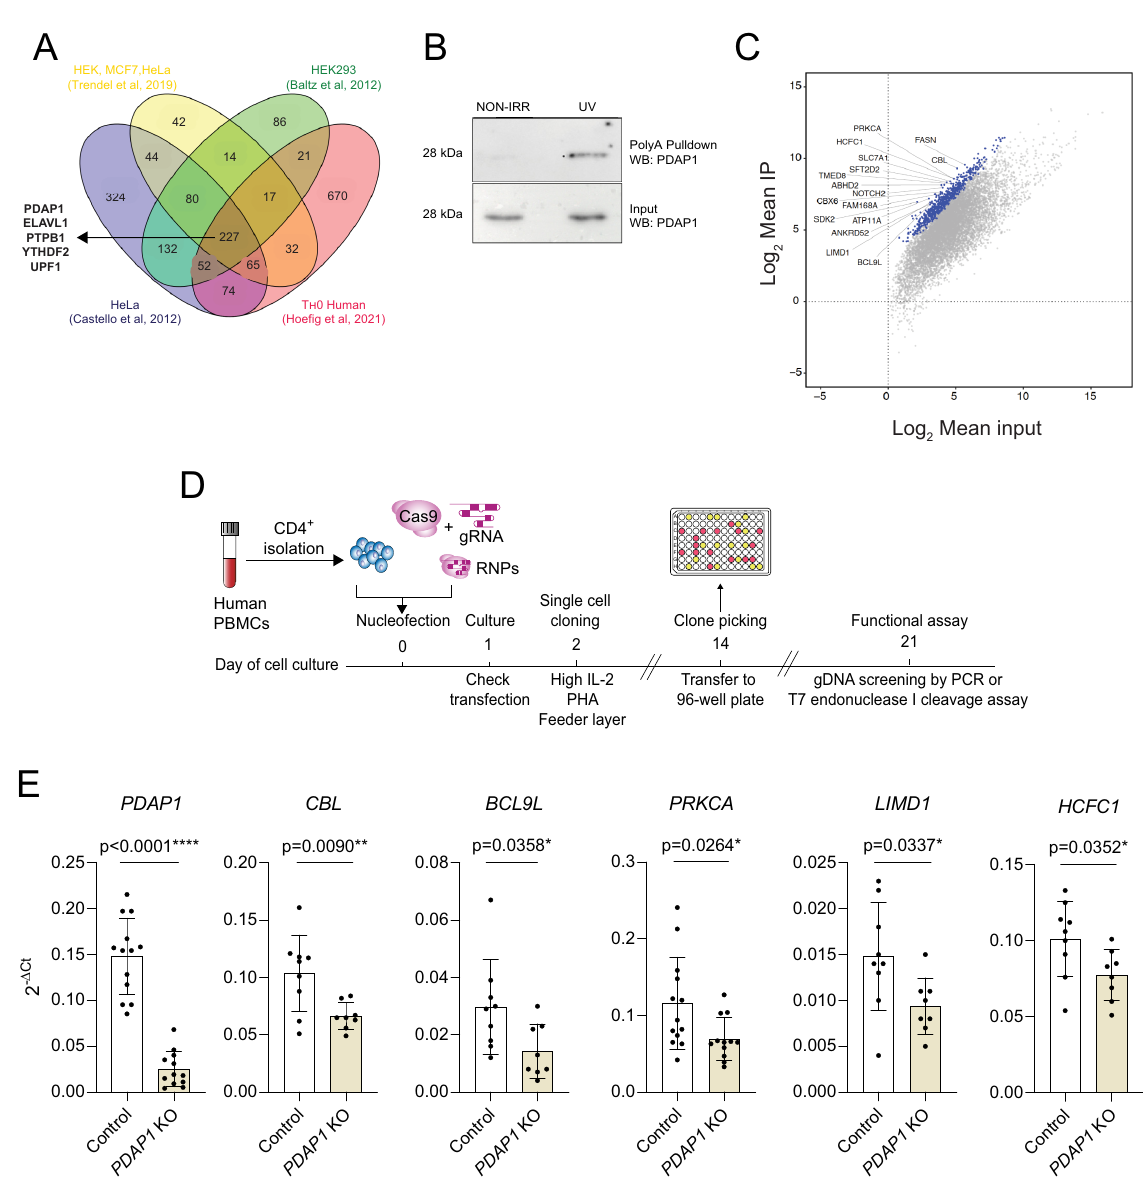
Fig 4. PDAP1 acts an RBP in primary human T lymphocytes. (A) Venn diagram showing the extentof overlap between RBPs identified in the indicated studies and cell types. (B) Activated memory T lymphocytes were UV-irradiated and lysed prior to poly-A mRNA pull-down and western blot. Nonirradiated samples were also used. Representative of N = 2 independent experiments. (C) Scatterplot of RIP-seq data ( N = 3 independent donors). Blue dots indicate transcripts significantly enriched (FDR < 0.001) in RIP samples compared to input controls, with log 2 FC � 2, as determined by DESeq2. All other mRNAs are indicated as gray dots. (D) Schematic representation of the experimental workflow to generate primary T lymphocytes KO for a protein of interest. (E) Primary human CD4 + memoryT lymphocytes were transfected with CRISPR/Cas-9 RNPs to delete PDAP1 ,followed by single-cell cloning and screening. Clones showing a prominent genomic deletion in the PDAP1 gene were used to measure the expression of PDAP1 itself and of other transcripts bound by PDAP1.Each dot representsone individual clone (at least N = 8). Statistical test is unpaired t test or Mann–Whitney, depending on the distribution of the clones. Mean ± SD. Underlying data can be found in S1 Data.FDR, false discovery rate; FC, fold change; gDNA, genomic DNA; gRNA, guide RNA; KO, knockout; PBMC, peripheral blood mononuclear cell; PDAP1, PDGFA-associated protein 1; RBP, RNA-binding protein; RIP-seq, RNA immunoprecipitation sequencing; RNP, ribonucleoprotein.